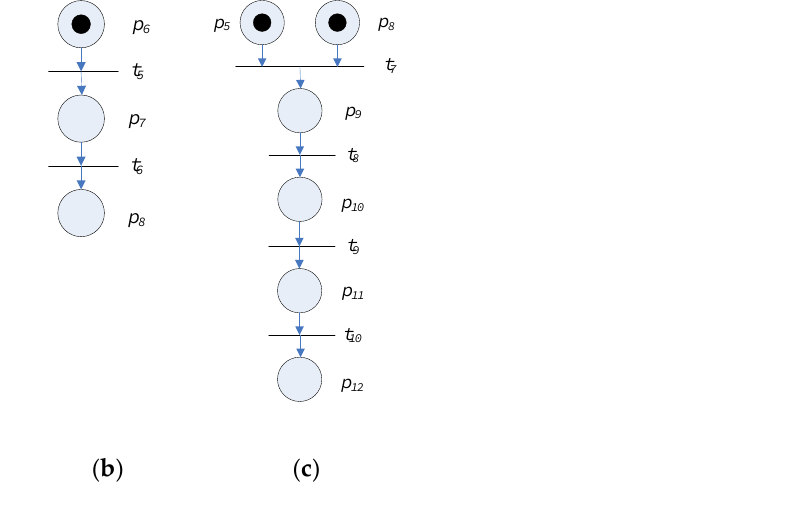
Figure 7. ( a ) A DTPN model Ω 1 for process agent W 1; ( b ) A DTPN model Ω 2 for process agent W 2; Figure 7. ( a ) A DTPN model 1  for process agent 1 W ; ( b ) A DTPN model 2  for process ( c ) A DTPN model Ω 3 for process agent W 3. agent 2 W ; ( c ) A DTPN model 3  for process agent 3 W . Each operation of process agent w n must be performed by some resource